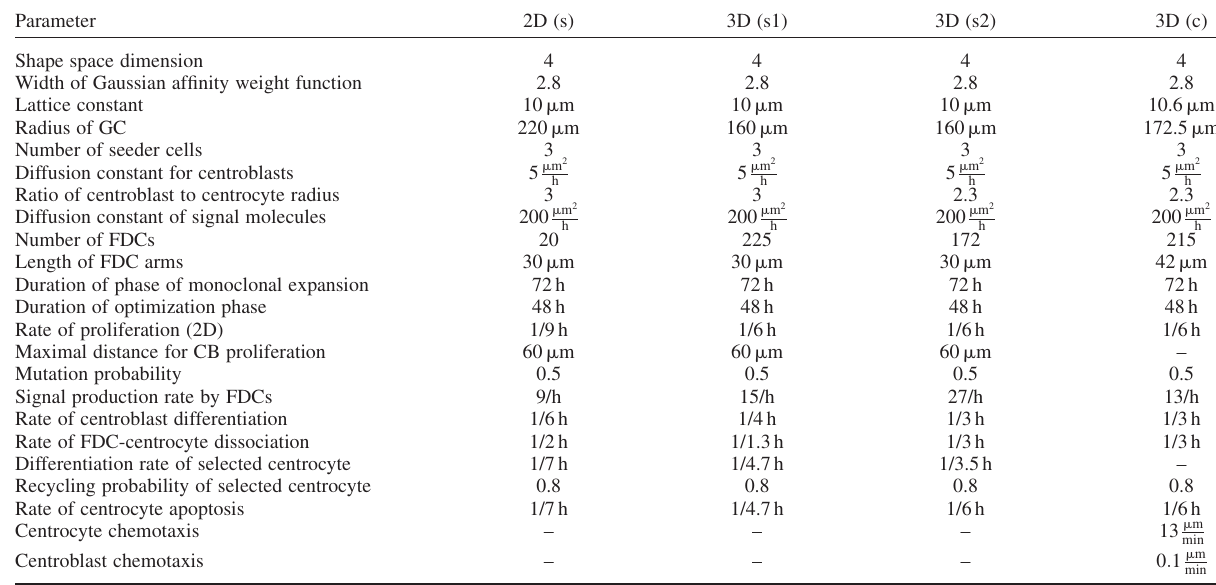
TABLE I The model parameter values: the parameter values as used in 2D (s) and 3D (s1) simulations using the signaling model are shown in the two left columns. The rates in 3D compare to thevalues in 2D simulations by an additional factor of 1.5. The right columns show the parameter values as used to compare the 3D signaling model (s2) with the chemotaxis model